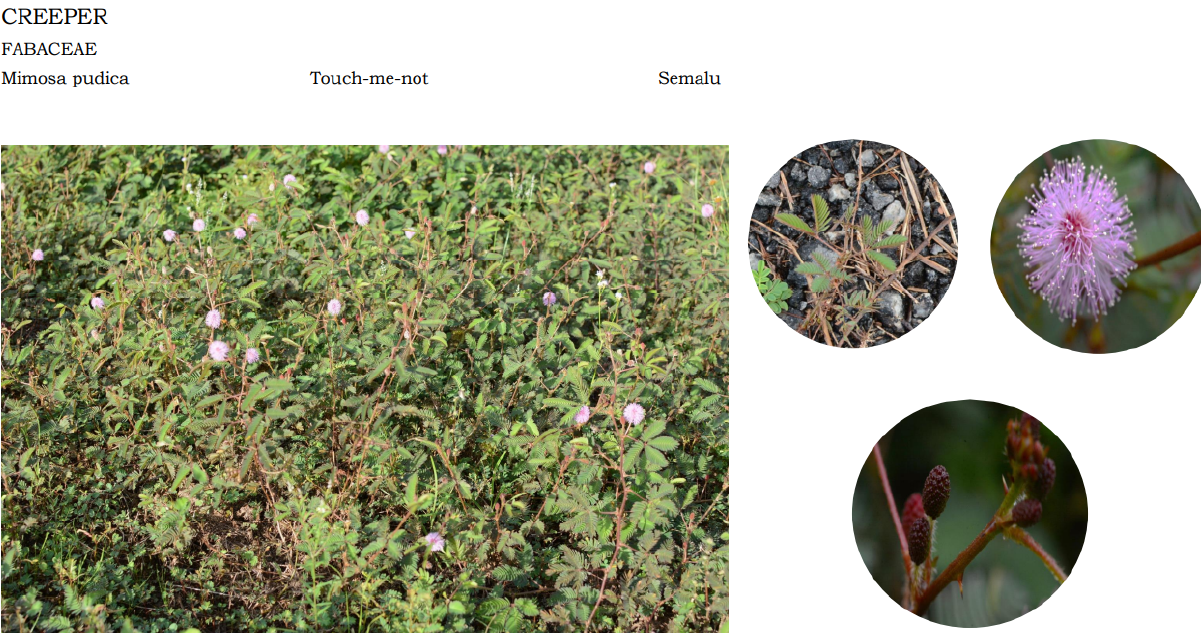
Figure A9. Creeper Fabaceae: Mimosa pudica.